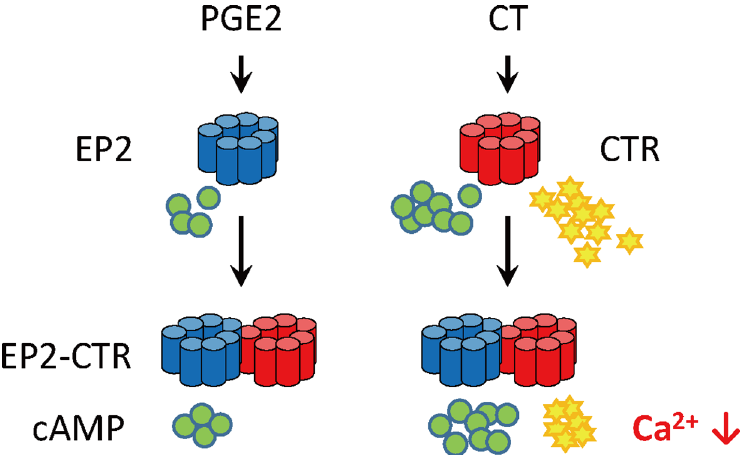
Fig 4. Signaling modulation via EP2-CTR heterodimerization. The EP2-CTR heterodimer suppressed CTR-mediated Ca 2+ mobilization, comparedwith the CTR monomer/homodimer. cAMP production inducd by either PGE2 or CT was not affected by